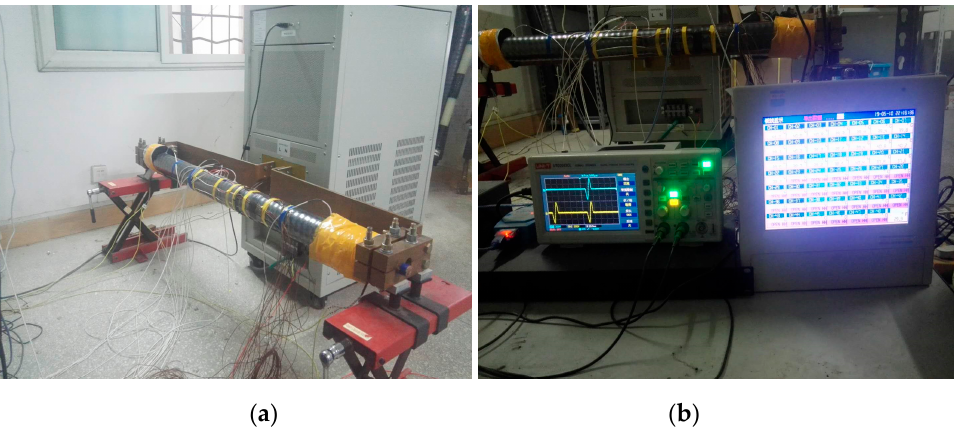
Figure 1. High-voltage cable thermal parameter detection control platform. ( a ) Ampacity experimental cable and AC constant current source, ( b ) thermal compensation system and paperless recorder. Table 2. Critical thermal parameters and ampacity of the cables.